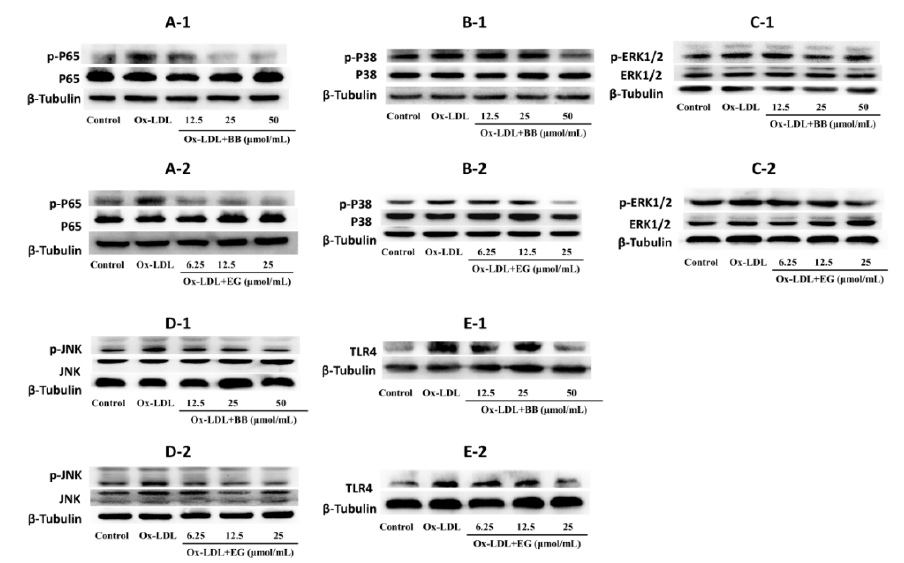
Figure 6. p-P65/P65 ( A-1 , A-2 ), p-P38/P38 ( B-1 , B-2 ), p-ERK1/2/ERK1/2 ( C-1 , C-2 ), p-JNK/JNK ( D-1 , D-2 ), and TLR4 ( E-1 , E-2 ) protein expression in RAW264.7 macrophages. Data were collected at least three times.